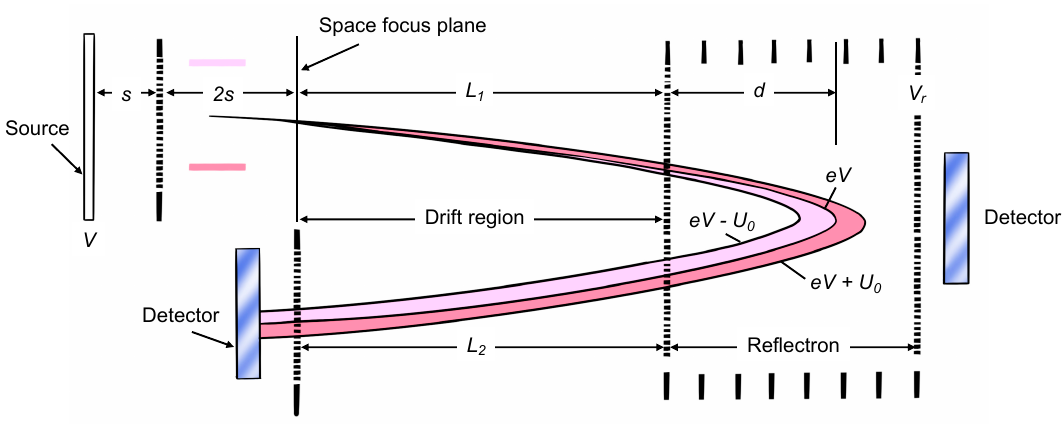
Figure 2. The schematic diagram of TOF mass spectrometer including “reflectron” [18].